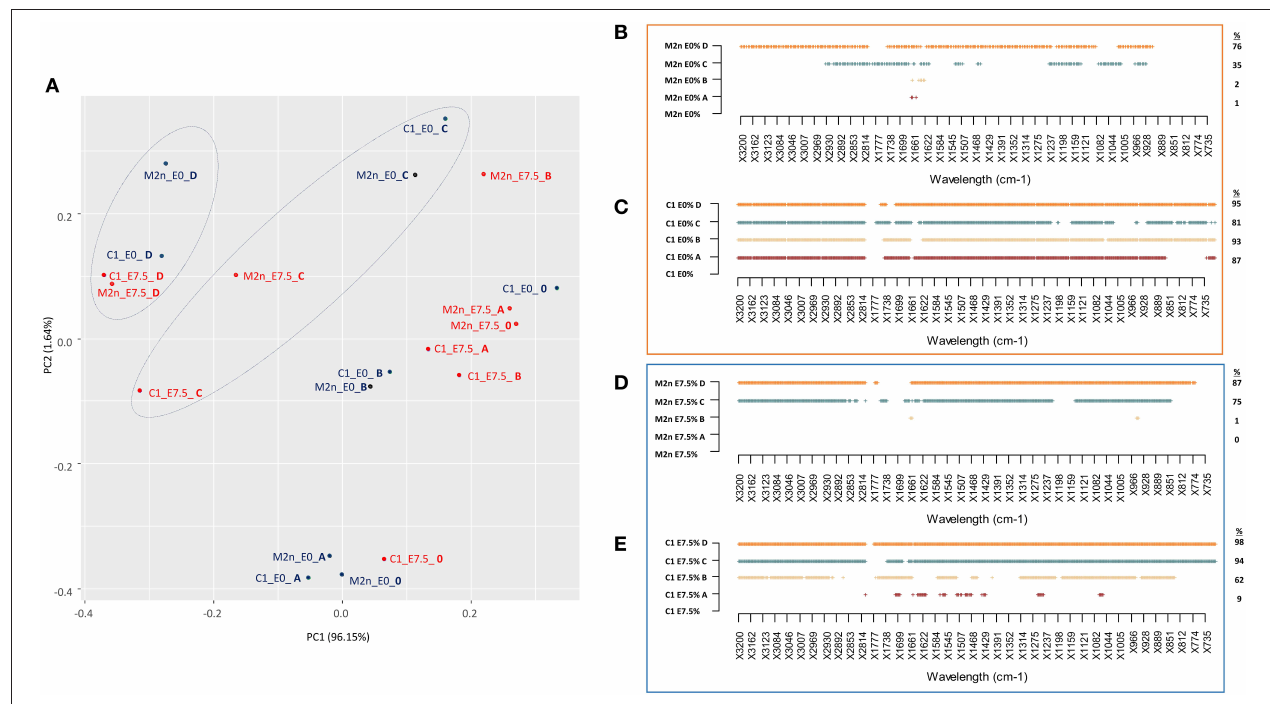
FIGURE 5 | Stress response of S. cerevisiae M2n and C1 strains to increasing concentrations of lignocellulosic inhibitors mixtures formulated with 0 or 7.5% of ethanol. (A) PCA score plot obtained from the IR spectra of M2n and C1 strains at 0% (blue) and 7.5% (red) ethanol. (B,C) SWA patterns of significant wavelengths ( p < 0.01) throughout spectra of (B) M2n and (C) C1 cells exposed to increasing concentrations of inhibitor mixture at 0 or 7.5% ethanol, respectively. (D,E) SWA patterns of significant wavelengths ( p < 0.01) throughout spectra of (D) M2n and (E) C1 cells exposed to increasing concentrations of inhibitor mixture with 0 or 7.5% of ethanol, respectively. The percentages (%) of wavelengths of C1 spectrum significantly different from that of M2n are also